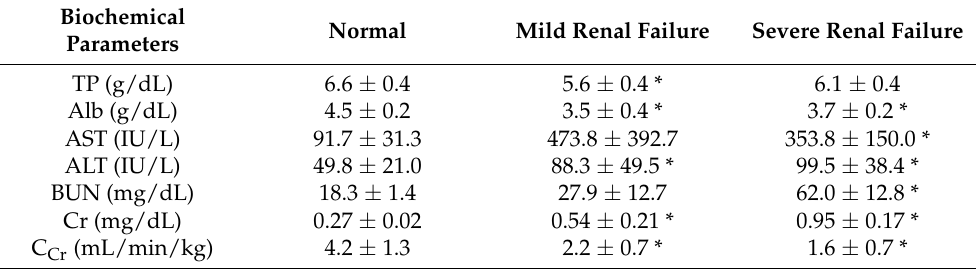
Table 1. Biochemical parameters of normal, mild, and severe renal failure model